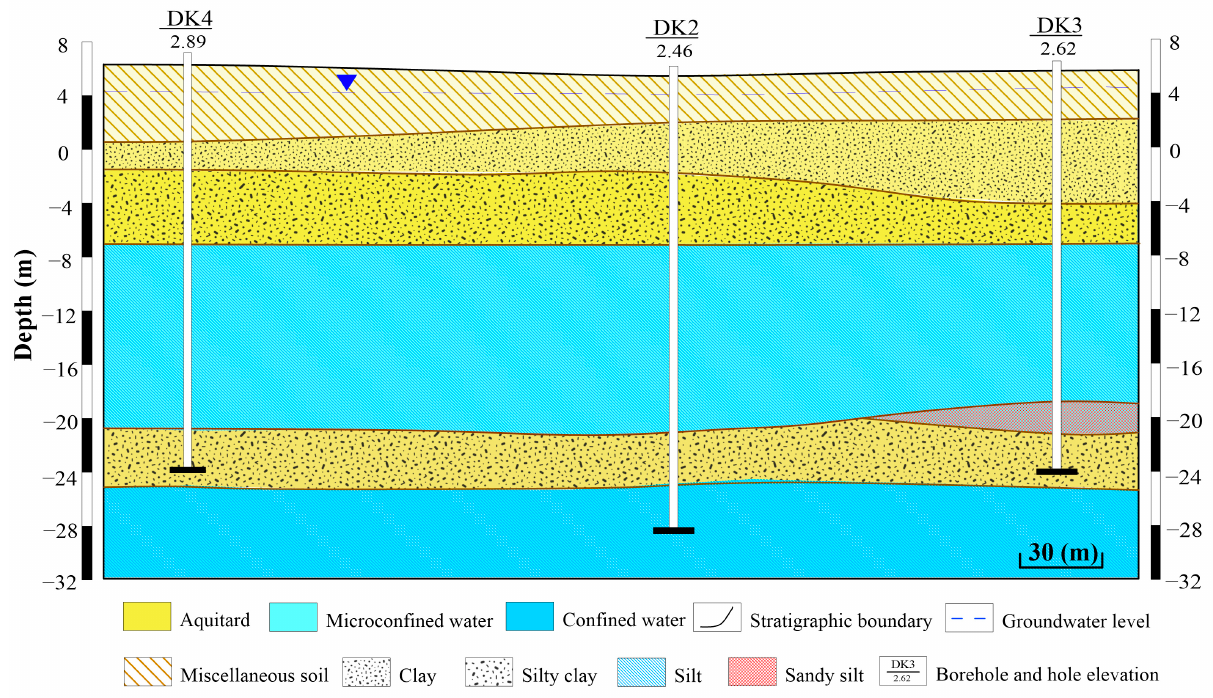
Figure 2. Hydrogeological cross section of study area.